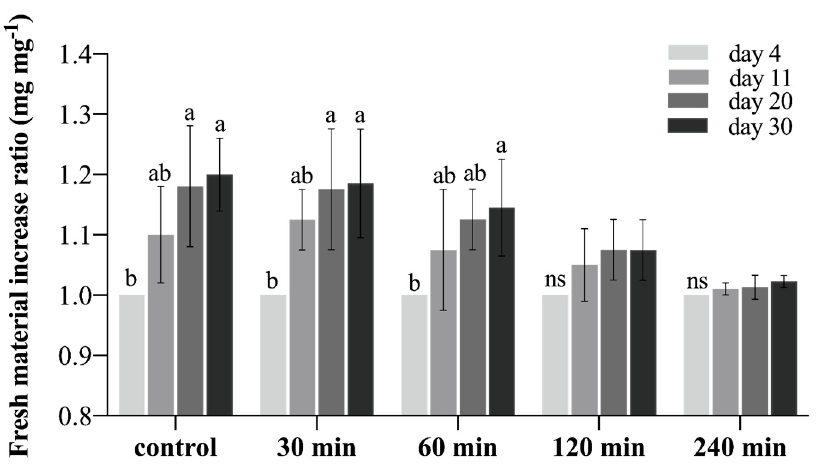
Figure 2. Fresh mass increased ratio (mg mg − 1 ) of G. chacoensis embryogenic cultures subjected to different incubation times (control–0, 30, 60, 120, and 240 min) in cryoprotective solution after 4, 11, 20, and 30 days. Bars indicate the standard deviation of the mean. Lowercase letters represent significant differences between dates in each incubation time, according to the Tukey test ( p < 0.05). ns: not significant.